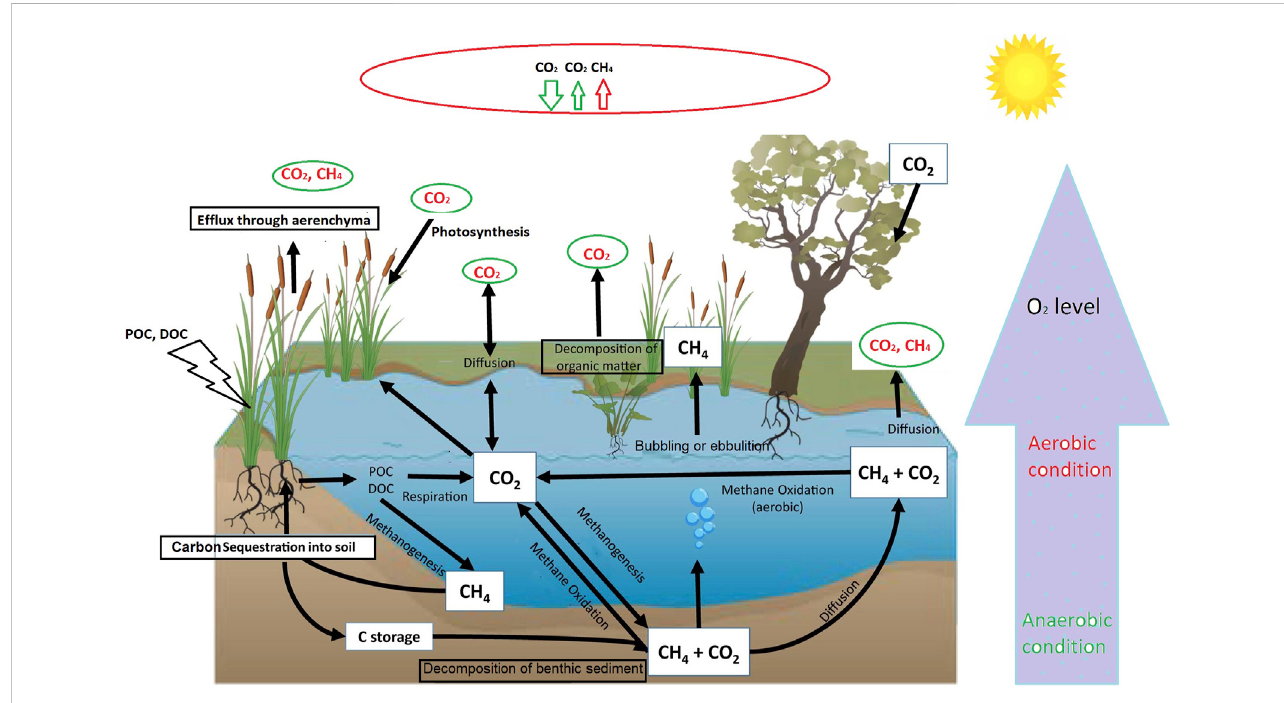
FIGURE 1 Schematicdiagramofwetlandemission,transport,andpathways[modi fi edfromLimpertetal.,2020;particulateorganicmatter(POC),dissolvedorganic carbon